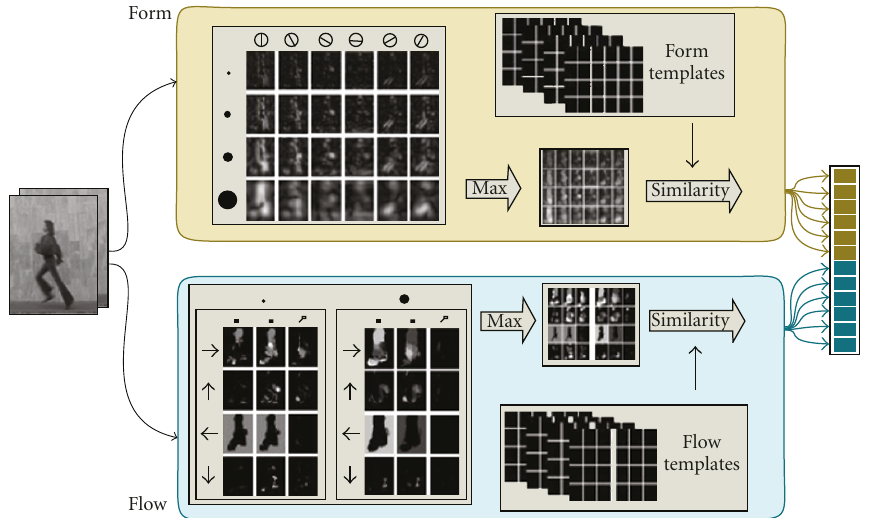
Figure 3: The features we use for unsupervised action recognition are described in [24], and are computed for each single frame of the video (left), while also considering the preceding one for computing optical flow. The resulting feature vector (right) consolidates data from two separate pathways computing form and flow, respectively. The former (top) computes gabor filter responses at di ff erent directions and scales; the letter in di ff erent directions, scales, and velocities. In both pathways, data is max-pooled for improving shift-invariance and summarized by matching with a set of templates.